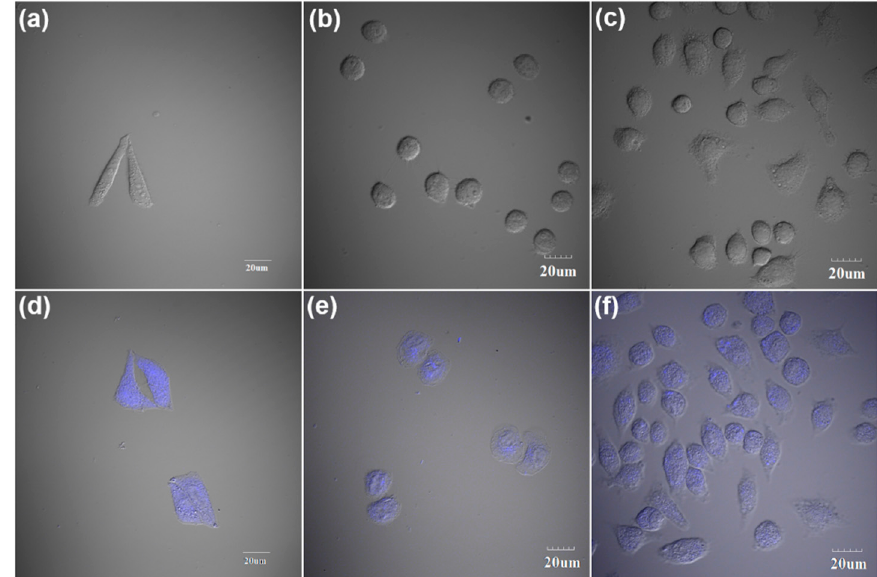
Figure 6. ( a – c ) Confocal microphotographs of live HeLa cells, L02 cells, and macrophage cells without NM-CQD incubation, respectively. ( d – f ) Confocal micro-photographs of live HeLa cells, L02 cells, and macrophage cells incubated with 40 µ L of NM-CQDs at 37 ◦ C for 3 h, respectively. Detection of